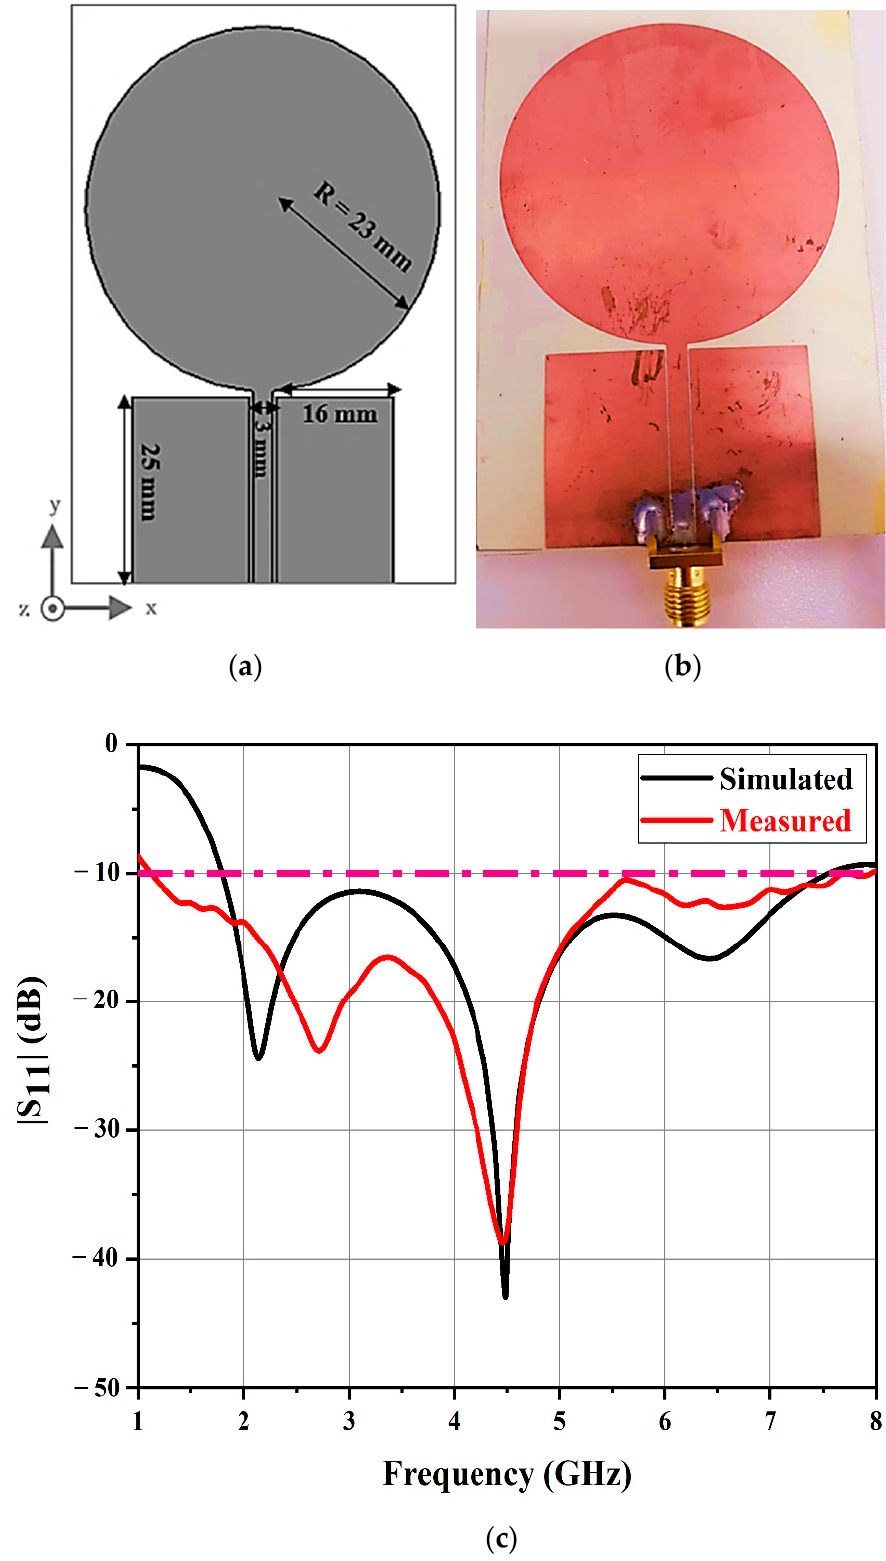
Figure 2. Dimensions of ( a ) the reader antenna and ( b ) the fabricated reader antenna. ( c ) Simulated and measured reflection coefficients of the reader antenna.